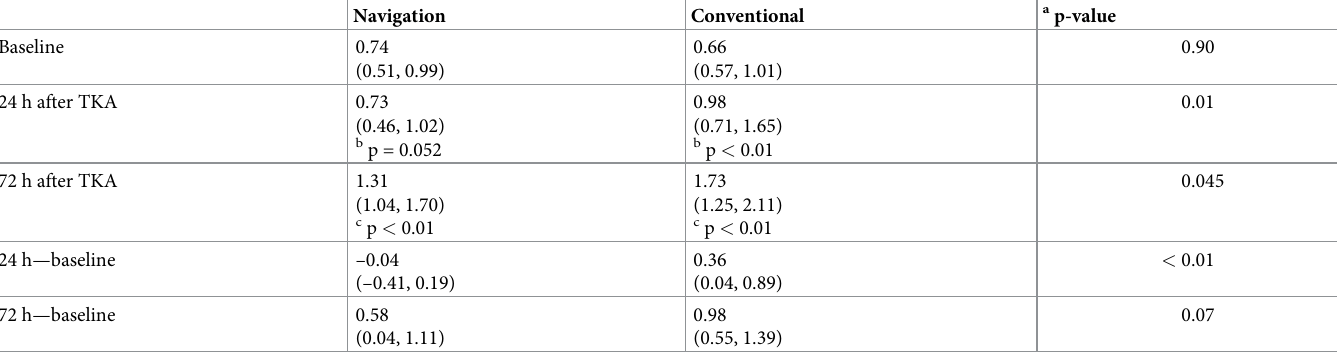
Table 4. Serum TNF- α concentrations (pg/mL) prior to TKA,then at 24 and 72 hours after